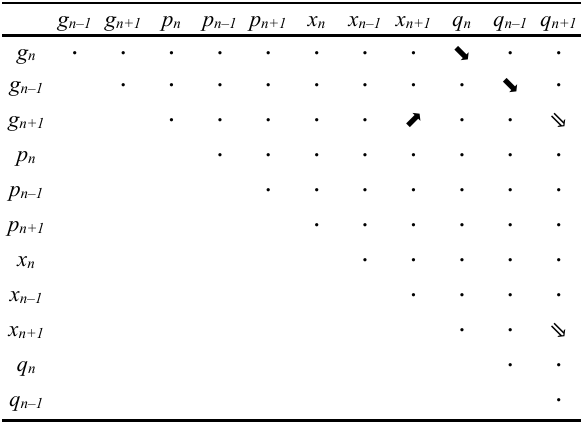
Table 2 Covariance Matrix for the Single Fixation Durations